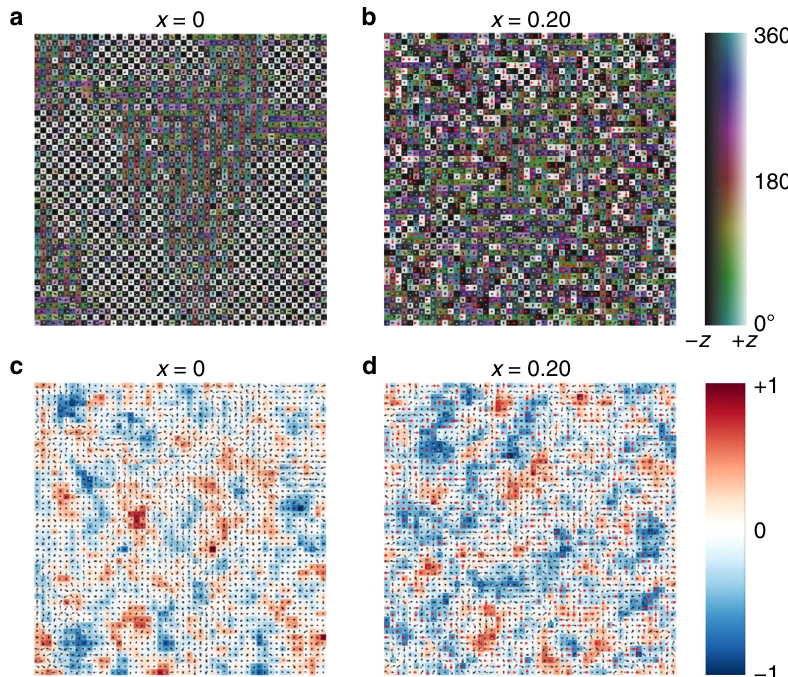
Fig. 6 Monte Carlo simulations of mixed MA 1 − x DMA x PbBr 3 perovskites. a , b Snapshots of Monte Carlo simulations and c , d potential energy landscape for a two-dimensional slice of a three-dimensional periodic slab representing MA 1- x DMA x PbBr 3 for a , c x = 0, and b , d x = 0.20. The orientations of the MA and DMA dipoles are represented by gray and red arrowheads, respectively. The MA dipole is allowed to freely rotate, however, the orientation of the DMA dipole is fi xed toward a <100> (or equivalent) lattice direction. The color bar in a , b represents the angle of the dipole with respect to the <100> direction; it is darkened towards <00-1> ( − z) and lightened towards <001> ( + z). The color bar in c , d shows the normalized electrostatic